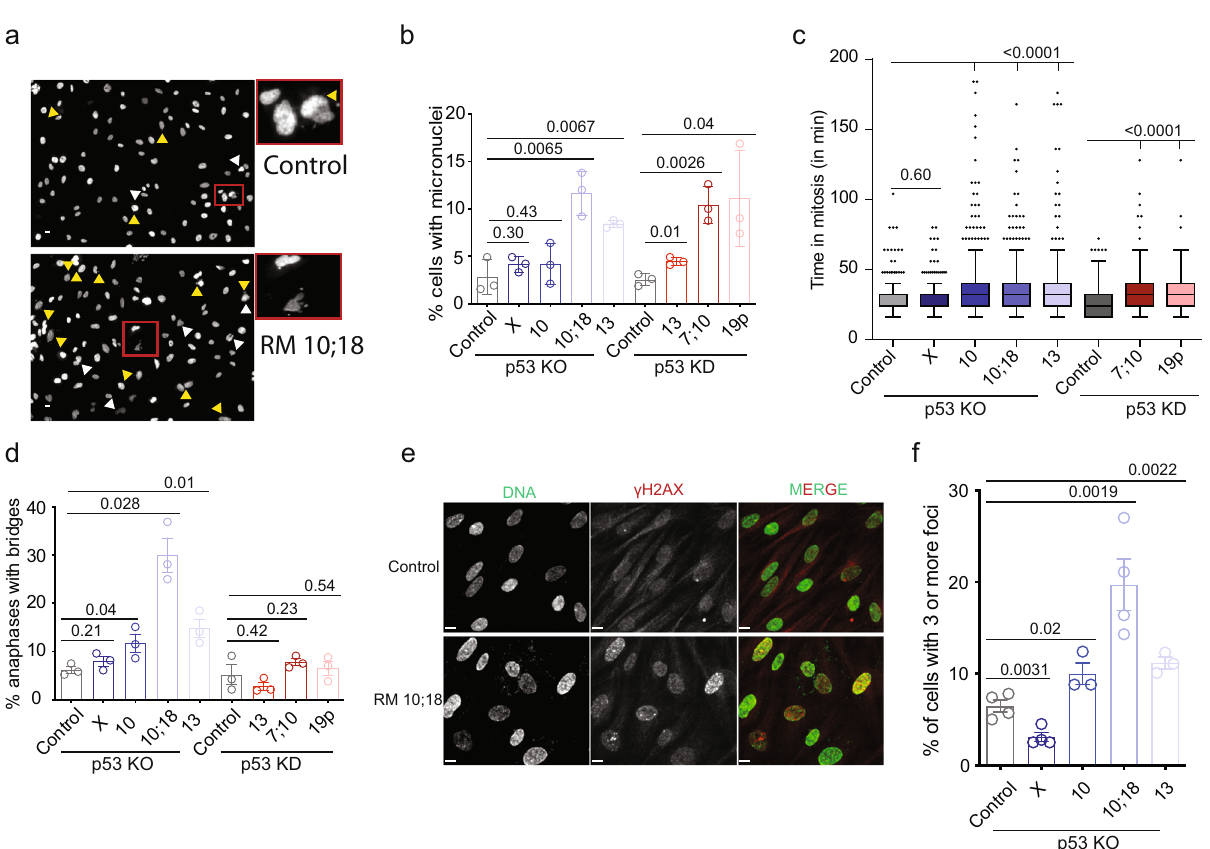
Fig. 2 Genomic instability is increased in monosomic cell lines. a Representative images of cells with micronuclei and nuclei structure abnormalities. Inset shows the enlarged fi eld (white arrowhead — nuclear abnormalities, yellow arrowhead — micronuclei). Three independent experiments were performed. Scale bar — 10 µ m. b Percentage of cells with micronuclei. Bar graphs display the mean ± SEM of three independent experiments. Number of cells analyzed (RPE1 P53 KO control = 1879, RM X = 2657, RM 10 = 3928, RM 10;18 = 2196, RM 13 = 2065; RPE1 P53 KD control = 2082, RM KD 13 = 2155, RM KD 7;10 = 1922, RM KD 19p = 2149). Statistical analysis was performed by comparing to the respective controls using two-tailed unpaired T -test; p -values are shown on the plot. c Quanti fi cation of time spent in mitosis. Time from nuclear envelope breakdown (NEBD) until the end of anaphase was measured. The median is shown as a black bar and whiskers are chosen to show the 1.5 of the interquartile range for four independent experiments. Number of cells analyzed (RPE1 P53 KO control = 358, RM X = 1161, RM 10 = 729, RM 10;18 = 446, RM 13 = 572; RPE1 p53 KD control = 754, RM KD 7;10 = 242, RM KD 19p = 149). Statistical analysis was performed by comparing to the respective controls using two-tailed unpaired T -test; p -value for all the comparisons was <0.0001 as shown on the plot. d . Percentage of anaphases with bridges. Bar graphs display the mean ± SEM of three independent experiments. Number of anaphases analyzed (RPE1 P53 KO control = 201, RM X = 198, RM 10 = 209, RM 10;18 = 162, RM 13 = 207, RPE1 P53 KD = 197, RM KD 13 = 144, RM KD 7;10 = 182, RM KD 19p = 189). Statistical analysis was performed by comparing to the respective controls using two-tailed unpaired T -test; p -values are shown on the plot. e Representative images shows immuno fl uorescence staining of the DNA damage marker γ H2AX in control and RM 10;18 cell lines. DNA is stained with sytox green (green) and γ H2AX (red). The fi gures are representative of three independent experiments. Scale bar — 10 µ m. f Quanti fi cation of percentage of cells with ≥ 3 γ H2AX foci per cell. Bar graphs display the mean ± SEM of four independent experiments, except for RM 10 and RM 13 with three independent experiments. Number of cells analyzed (Control = 2148, RM X = 2217, RM 10 = 1619, RM 10;18 = 1372, RM 13 = 1029). Statistical analysis was performed by comparing to the respective controls using one-tailed unpaired T -test; p -values are shown on the plot. Source data are provided in a Source Data fi